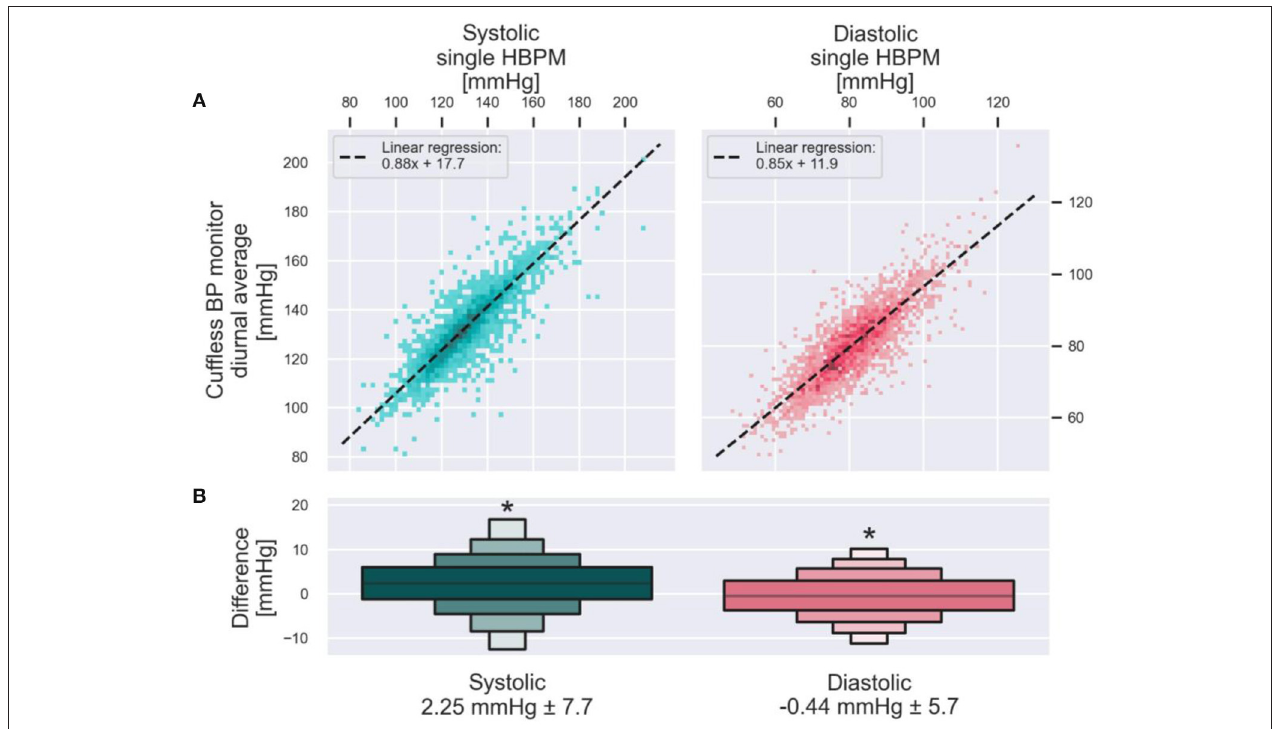
FIGURE 5 | Population comparison of daytime BP averages by a cuffless BP device against the HBPM measurements obtained during the initialization of the device on the same day. (A) Presents one data point from each of the 2,928 users of a continual cuffless BP monitor. On the X axis is the single measure from an HBPM read during the initialization of the device, compared on the Y axis with the concurrent diurnal (8am − 8pm) average BP measured by the cuffless device. Left, SBP. Right, DBP. The dotted line is calculated with a Huber linear regression. The letter-value plot on (B) depicts the distribution of the pairwise differences between the cuffless BP monitor values and the corresponding HBPM values. Mean and standard deviation of each distribution are presented on the bottom. Asterisks denotes statistically significant differences between the HBPM and cuffless BP monitors measurements (both p < 0.001).